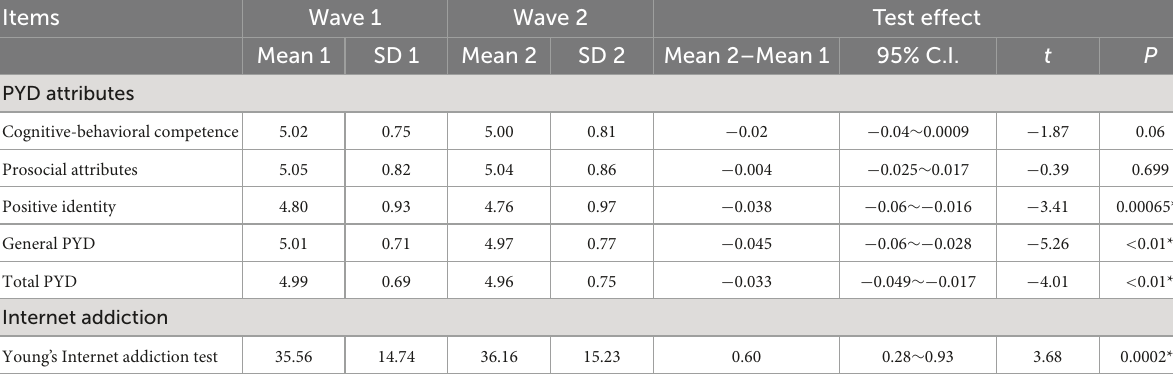
TABLE 2 PYD qualities and Internet addiction test scores among Chinese children and adolescents at two waves. Items